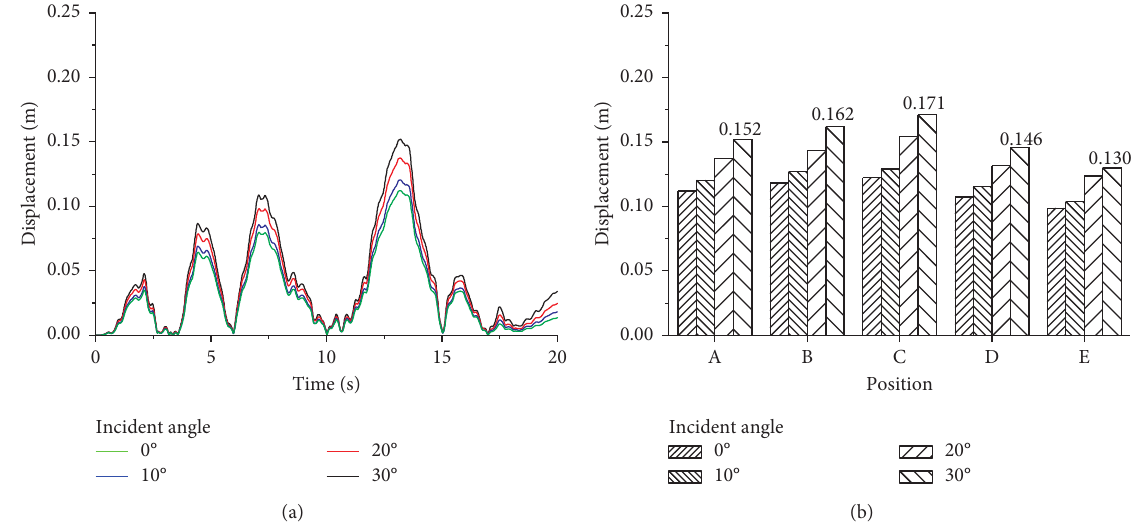
Figure 11: Displacement response under different incident angles: (a) displacement time histories of point A and (b) displacement peaks.